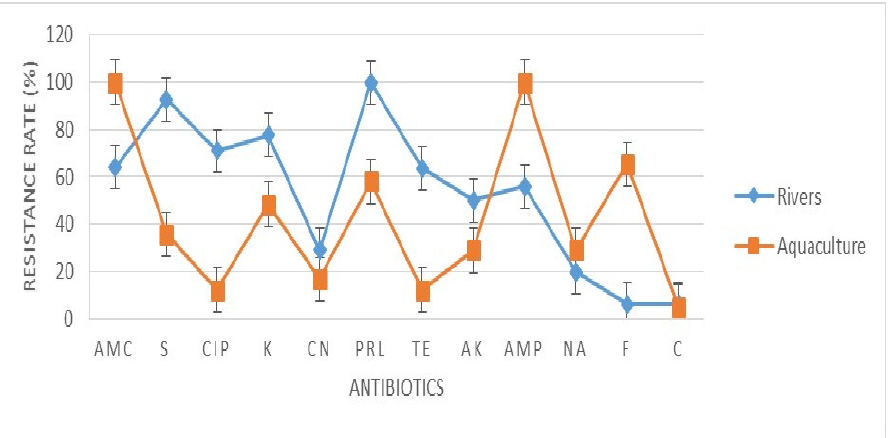
Figure 1. The antibiotic resistance rate (%) of Escherichia coli isolated from aquaculture farms and Sarawak Rivers against 12 antibiotics. AMC: amoxicillin, S: streptomycin, CIP: ciprofloxacin, K: kanamycin, CN: gentamicin, PRL: piperacillin, TE: tetracycline, AK: amikacin, AMP: ampicillin, NA: nalidixic acid, F: nitrofurantoin, C: chloramphenicol. Values represent the mean (%) of three replications. Vertical bars indicate the standard error of the means.